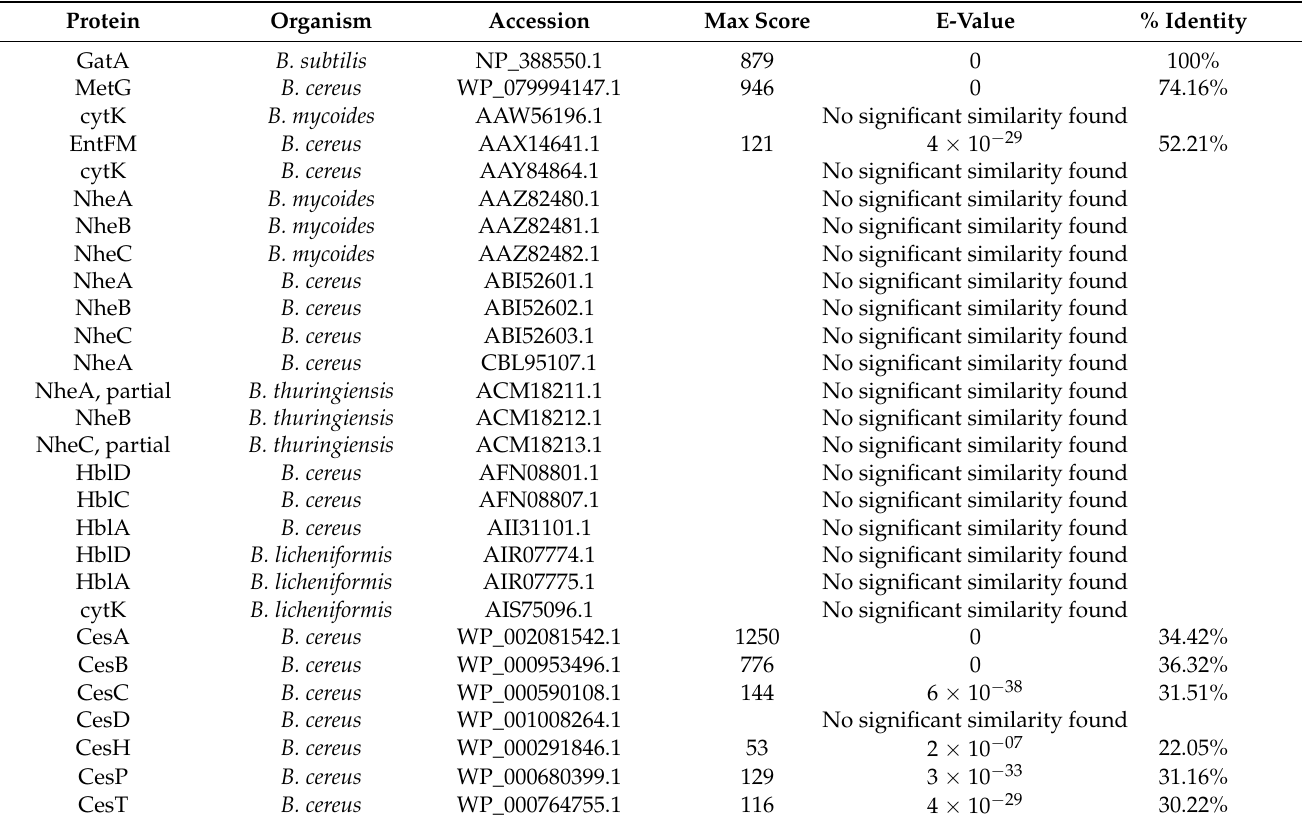
Table 2. Summary of BLASTx screening results for known Bacillus toxin genes in the BS50